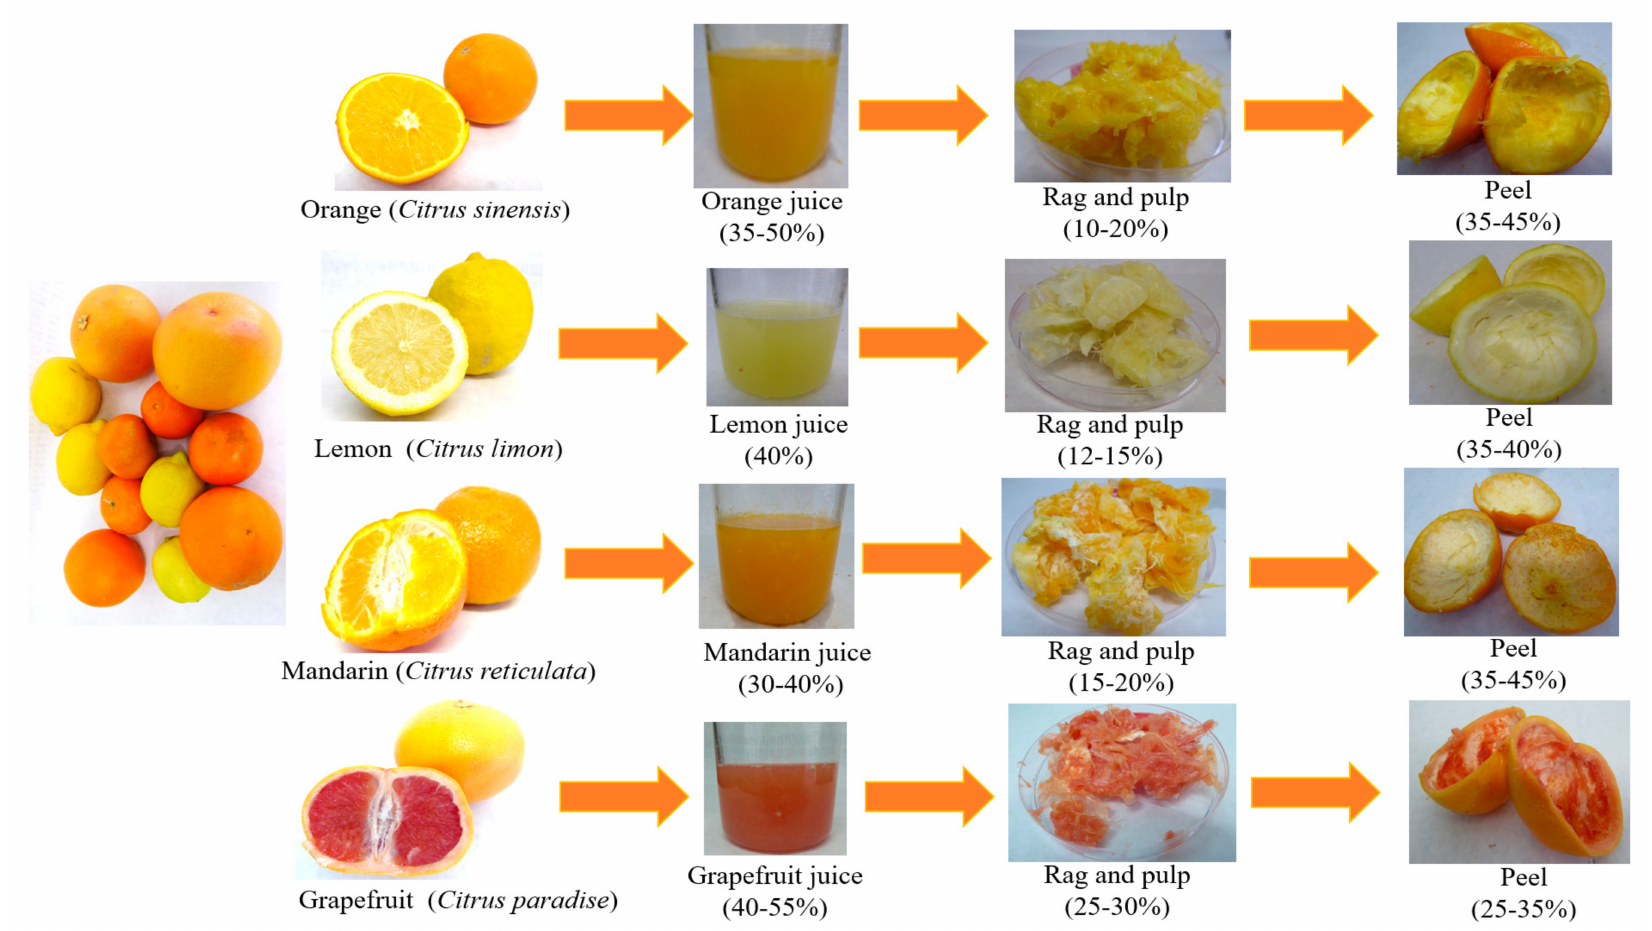
Figure 2. The principal citrus species and their composition in terms of juice and co-products composed by peel and rags and pulp